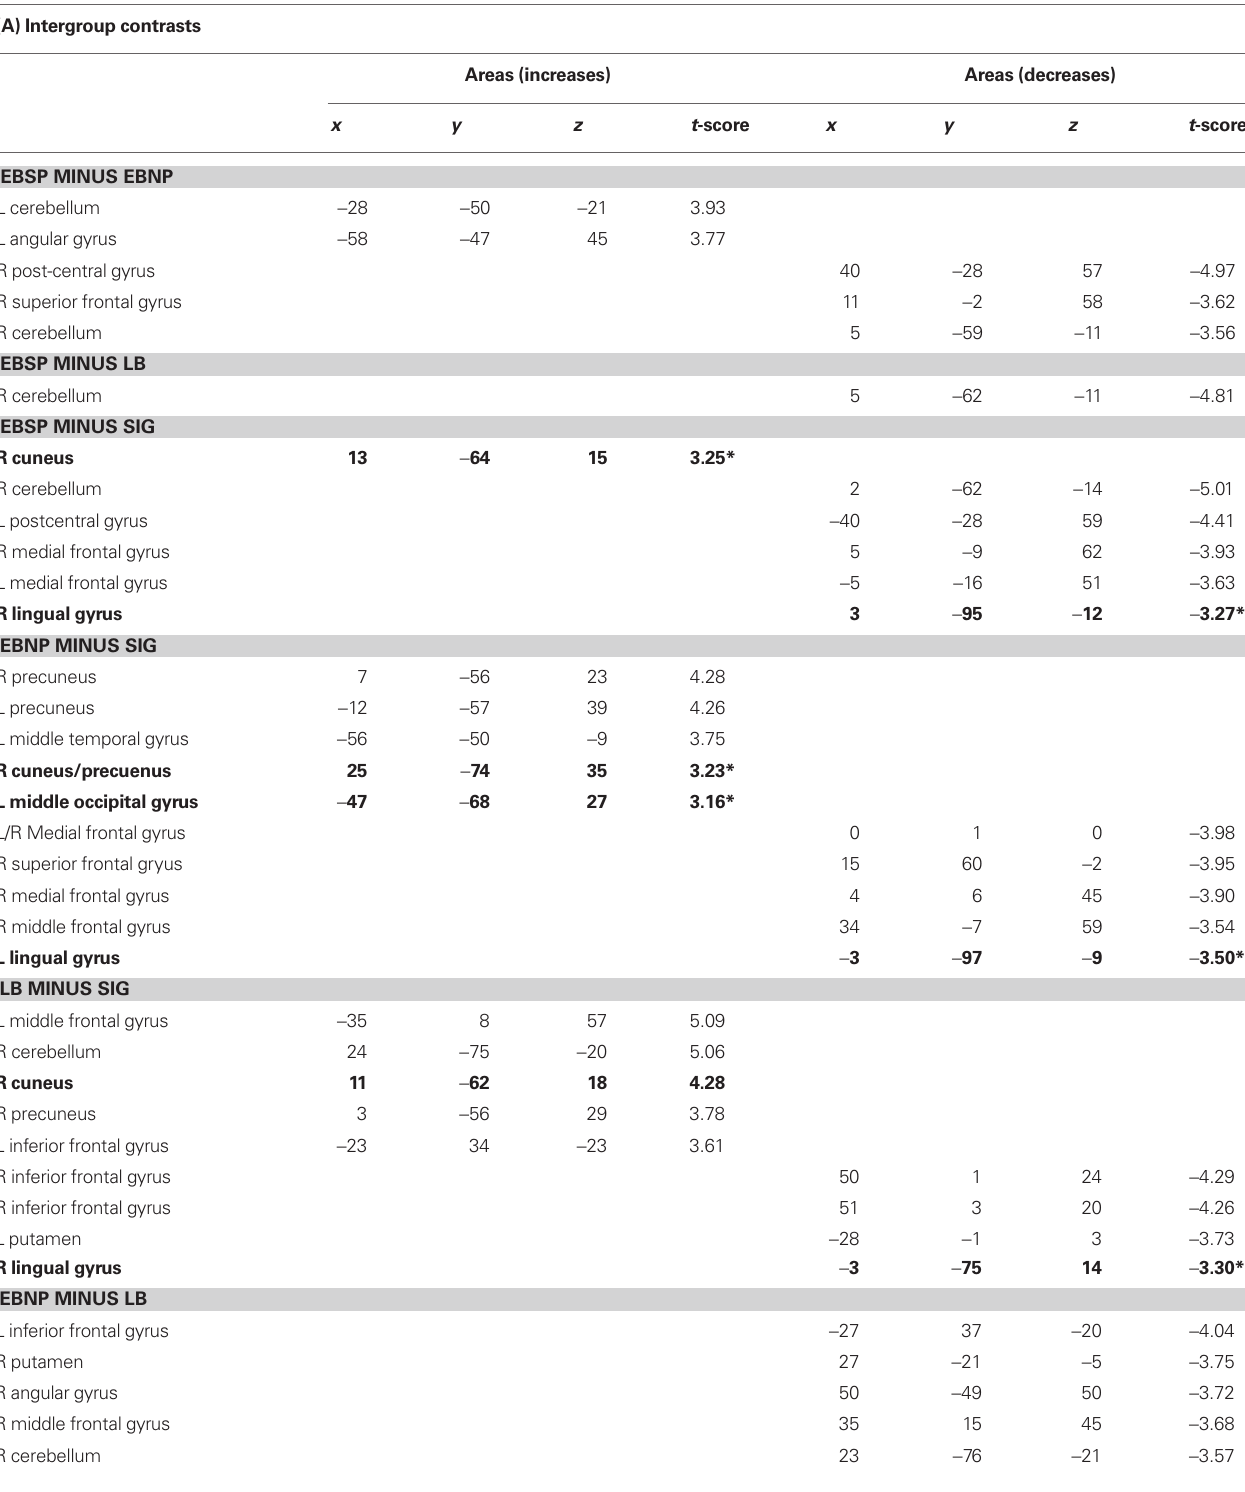
Table 2 | Stereotaxic coordinates and t -values of intergroup contrasts and functional connectivity analysis (coordinates refer to standardized stereotaxic space (Talairach and Tournoux,